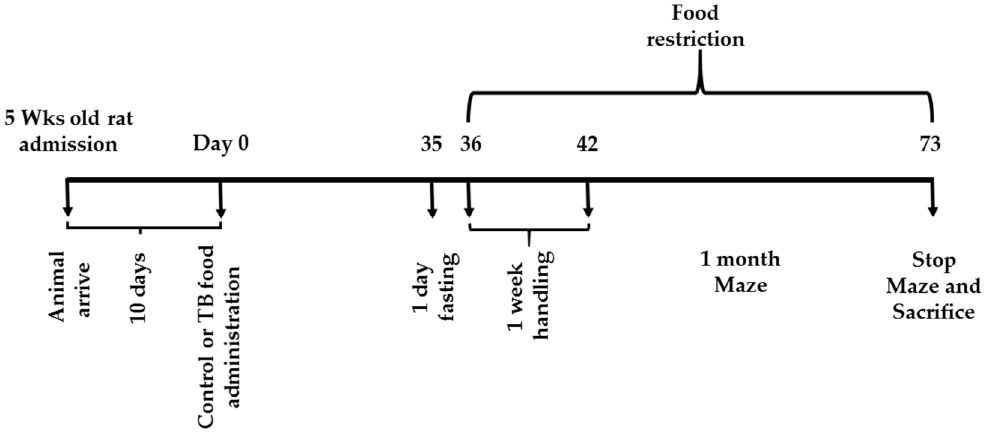
Figure 1. Schedule for Experiment 1 (radial arm maze (RAM) task).